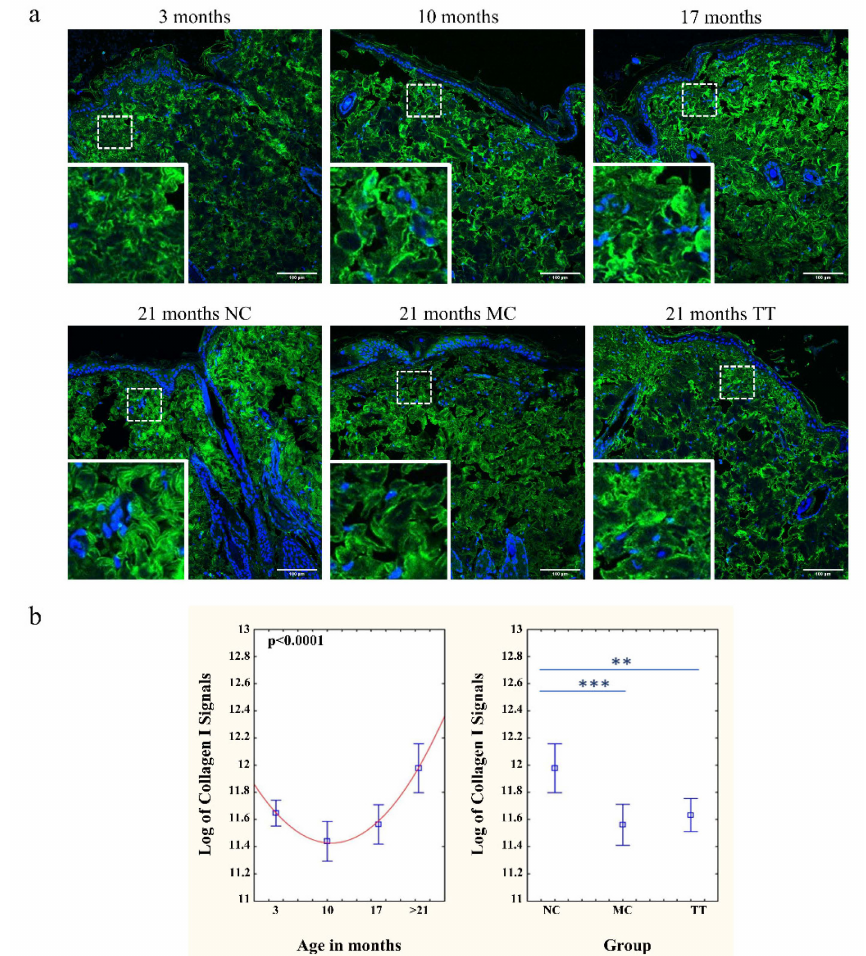
Figure 3. Implanted young fibroblasts change collagen I immunofluorescence pattern in aged skin. ( a ) Collagen I (green) in the untreated skin of rats of different ages (3, 10, 17 months) and in the untreated skin (NC), mechanically treated skin (MC), and skin treated with young cells (TT) of the same 21-month-old rat. The bottom left corner of each picture presents an enlarged selected area. Scale bar is 100 µ m. ( b ) Graphs represent CTCF for collagen I immunofluorescence signals in the skin of untreated rats (3, 10, 17, and >21 months, NC; left). Changes in collagen I signals of >21 months old animals following micro-transplantation procedure (NC, MC, TT; right). n = 3 per group; error bars represent mean ± 0.95 confidence intervals; ** p < 0.01; *** p <